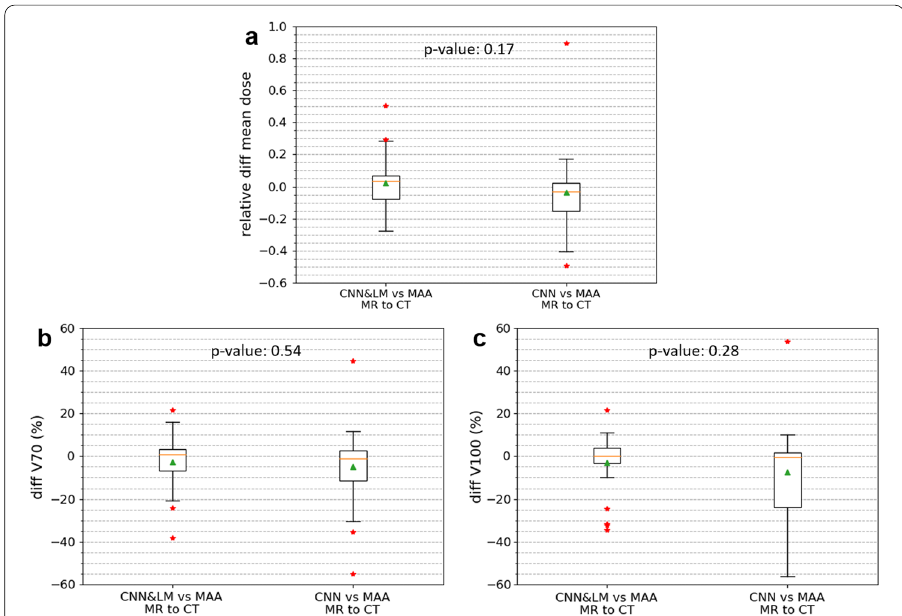
Fig. 11 Relative difference of mean dose ( a ) and difference of V70 ( b ) and V100 ( c ) between the reference and registered floating lesions using the CNN&LM-guided or CNN-guided MR to CT registration. MAA: the reference lesions. CNN&LM: the floating lesions registered by the CNN&LM-guided registration. CNN: the floating lesions registered by the CNN-guided registration. The relative difference of mean dose is computed by (mean dose (floating) – mean dose (reference)/mean dose (reference)). The difference of V70 and V100 is computed by (V70 or V100 (floating) – V70 or V100